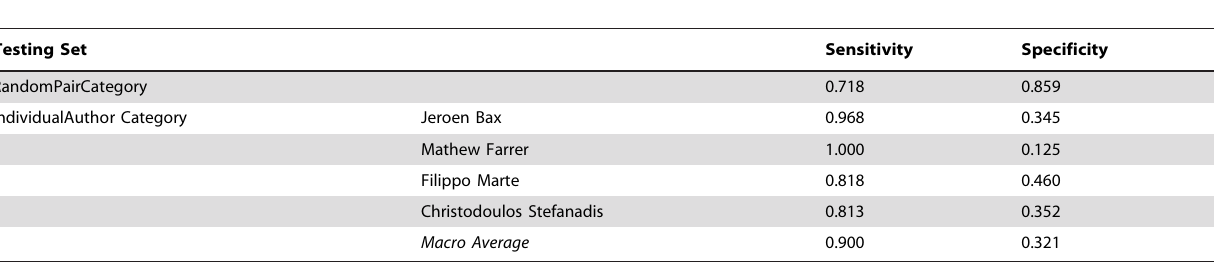
Table 7. Sensitivity and specificity for all testing sets by logistic regression model.